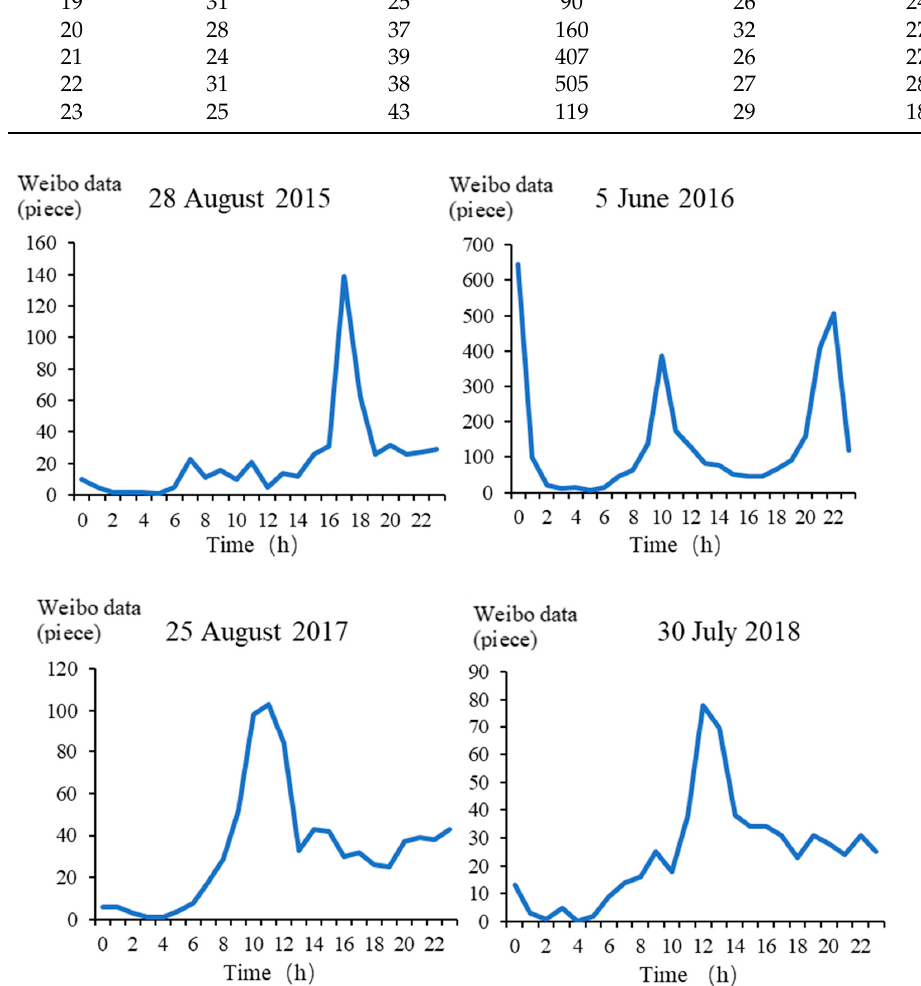
Figure 9. Process lines drawn from the unstructured data of the partial